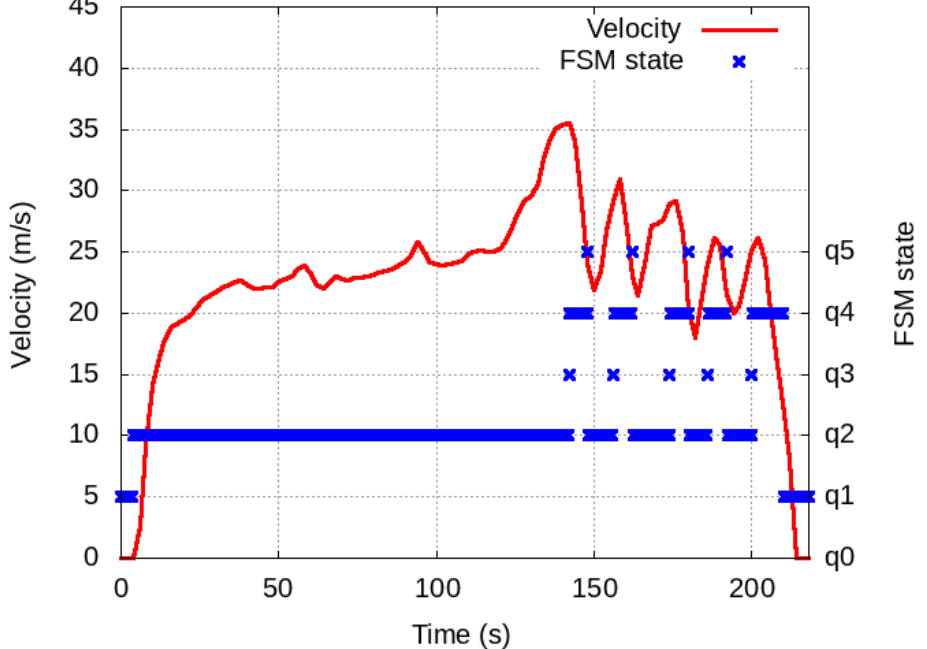
Figure 7. Velocity and FSM states diagram, created from data logged during the 1st lap of the Shell Eco-marathon Europe